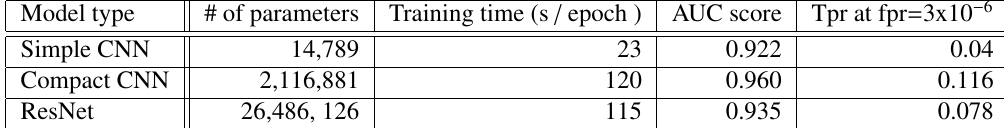
Table 1: Comparison of selected trained models. tpr and fpr stand for true positive rate and false positive rate respectively, while AUC stands for area under the ROC curve. Simple CNN is a layered CNN with very few number of parameters, Compact CNN is the best performing model and ResNet is the model used in the previous paper [1]. The training times are obtained by running on a Titan X (Pascal)